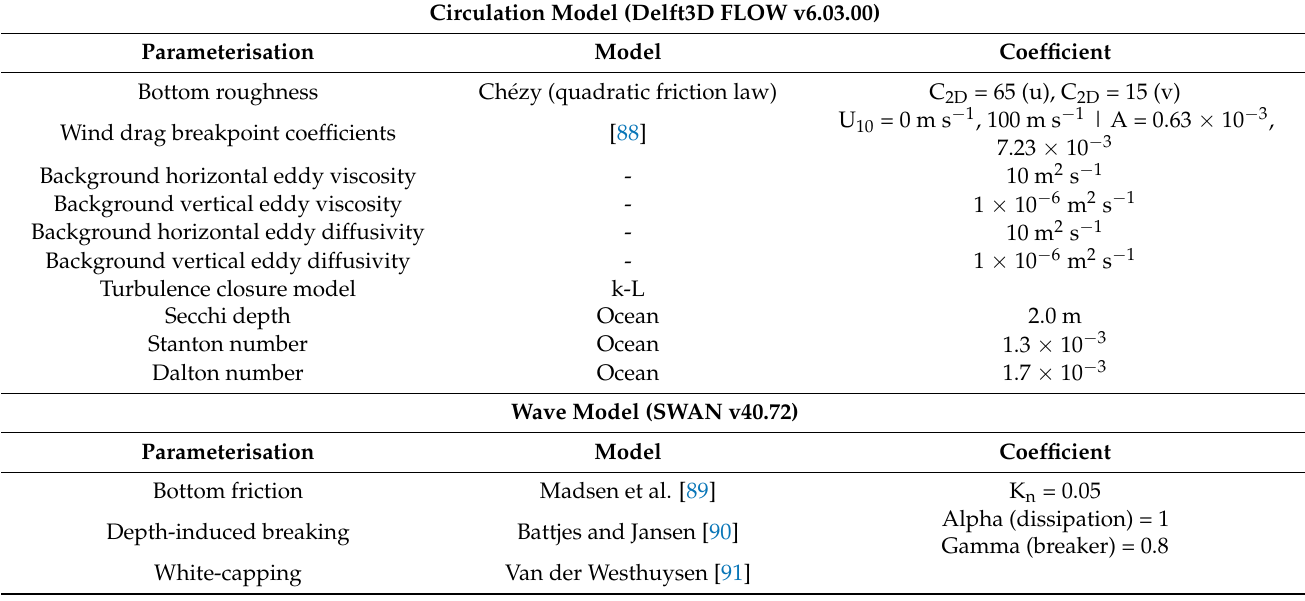
Table 1. Final model parameterisation settings, as determined via an iterative calibration process. Circulation Model (Delft3D FLOW